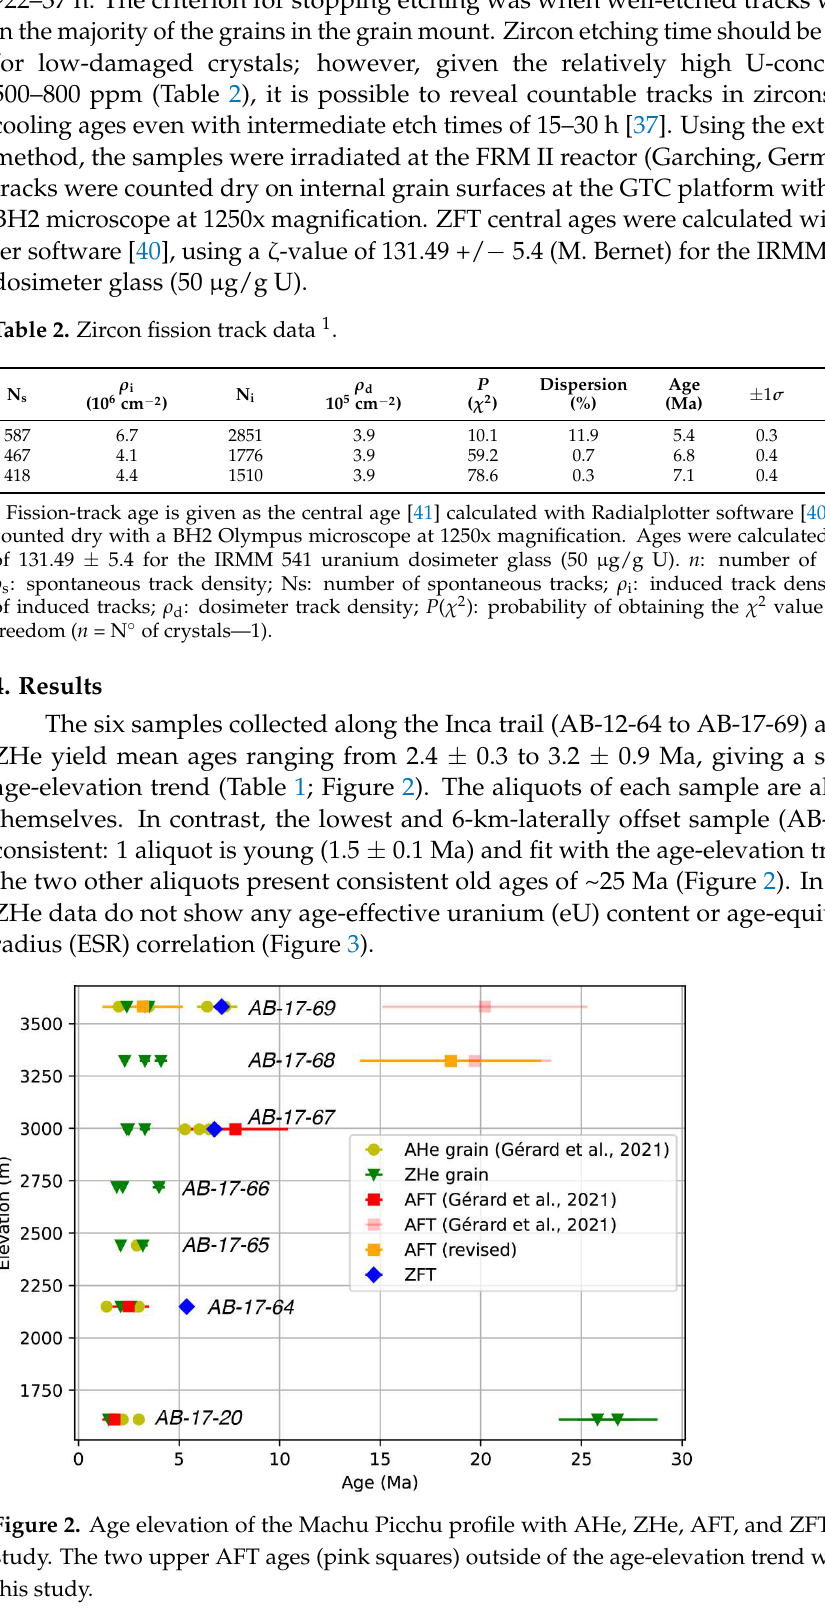
Figure 3. ZHe grain age of all the samples from the Machu Picchu vertical profile as a function of the equivalent uranium concentration (eU; left panel) and the equivalent sphere radius (ESR, right panel). Error bars are mostly smaller than the size of the points. There are no clear trends. The three new ZFT data range from 5.4 ± 0.3 Ma (AB-17-64) to 7.1 ± 0.4 (AB-17-68) (Table 2), are consistent with the other thermochronometers following the same age-ele- vation trend (Figure 2; supplementary materials figures S3 to S5). These new ZHe and ZFT data are much younger and thus apparently incompatible with the two highest AFT ages (AB-17-68 and AB-17-69 from [20]) in the profile. We thus revised the counting of these two AFT samples (Figure 2; Supplementary Materials Fig- ures S1 and S2). In fact, both of the highest AFT samples are difficult to date because of